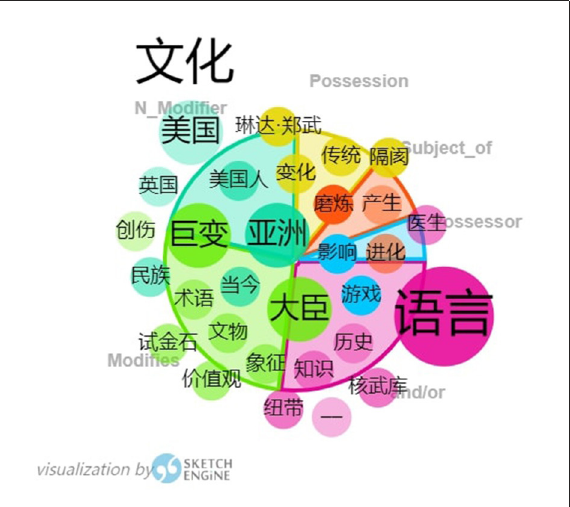
FIGURE4 Word sketch of “ 文 化 ” (culture) in the Chinese